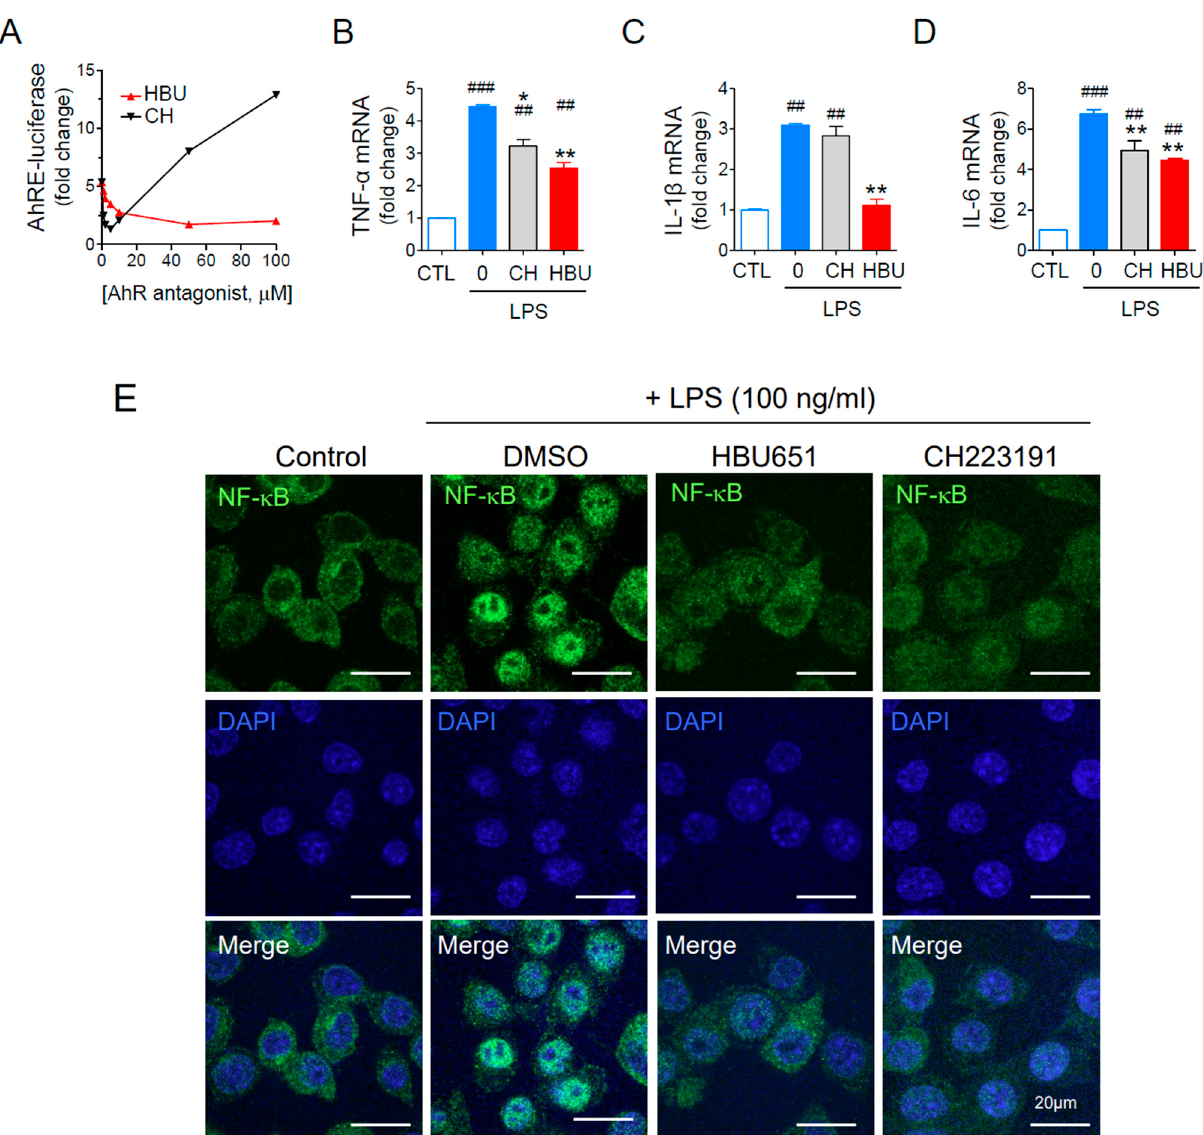
Figure 1. Effects of AhR antagonists on inflammatory cytokines and mitochondrial activities. ( A ) Dose-dependent AhR antagonist activity assay using AhR-dependent luciferase (AhRE-luciferase) assay. The cells were pretreated with AhR antagonists for 1 h, stimulated with 50 pM TCDD for 24 h, and assayed for luciferase activity. ( B – D ). Murine BV2 microglial cells were pre-treated with 10 μ M HBU651 (HBU) or 1 μ M CH223191 (CH) for 24 h, stimulated with 100 ng/mL LPS for 4 h, and harvested for analysis. Realtime qRT-PCR for TNF- α ( B ), IL-1 β ( C ), and IL-6 ( D ) mRNA levels. Data are expressed as the mean ±SEM ( n = 5). ## p < 0.01, ### p < 0.001 vs. Control (CTL), and * p < 0.05, ** p < 0.01 vs. LPS-treated DMSO. ( E ) Effect of HBU651 on LPS-induced nuclear localization of NF- κ B. Murine BV2 microglial cells were pre-treated with 10 μ M HBU651 or 1 μ M CH223191 for 24 h, prior to 100 ng/mL LPS stimulation for 4 h. BV2 cells were immunostained with NF- κ B p65/RELA anti- body (green) and DAPI (blue) for nuclei (Merge). Cell images were enlarged to visualize the nuclear localization of NF- κ B (Enlarged). Representative confocal micrograph images of BV2 cells are shown (scale bar = 20 μ m).